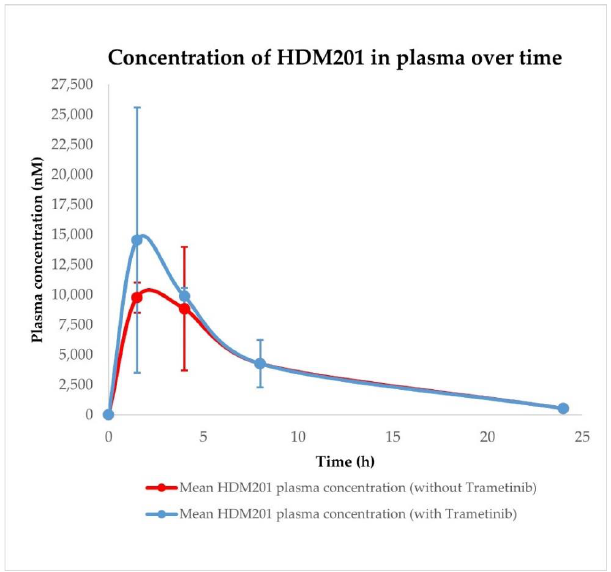
Figure 5 . Pharmacokinetic profiles of HDM201 (Siremadlin) in plasma after administration with and without Trametinib. Observed data are means ± standard deviation (SD) from n = 3.